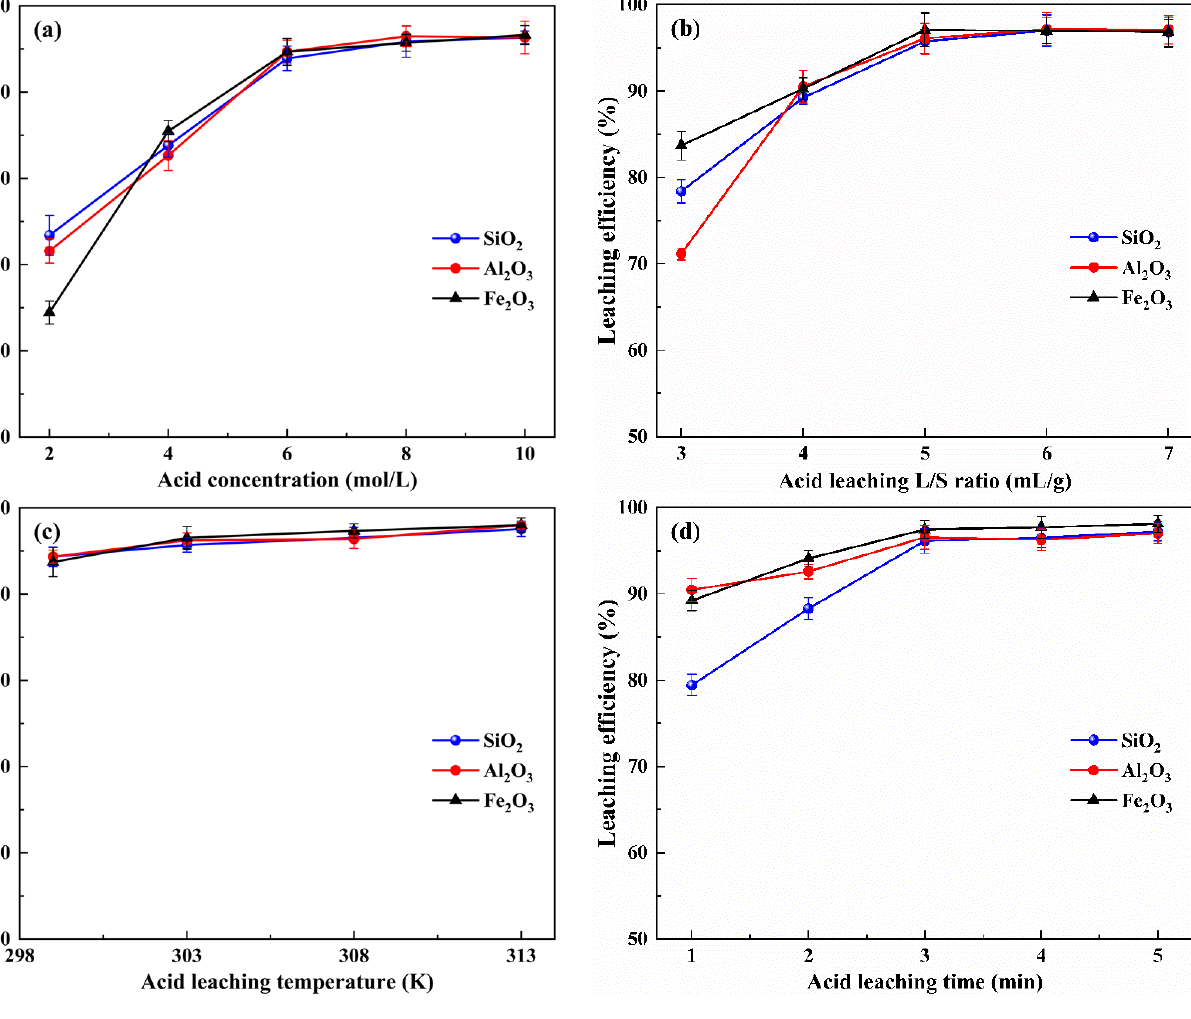
Figure 4. Effects of different acid leaching conditions on the leaching efficiencies of silicon, aluminum and iron: ( a ) acid concentration ( b ) liquid–solid ratio ( c ) leaching temperature and ( d ) leaching time.